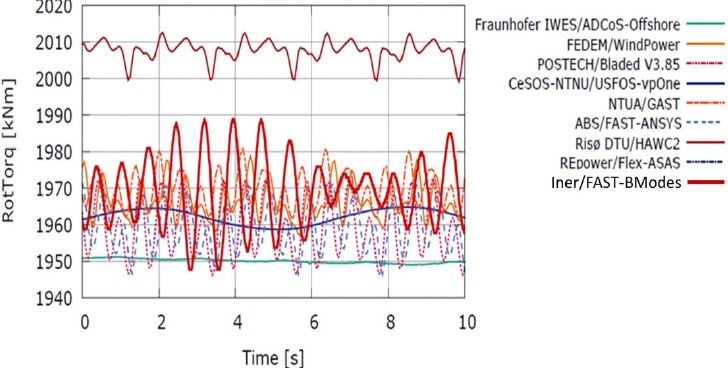
Figure 13. Analysis Result for Load Case 3.2 of OC4 Phase I (Low ‐ Speed Shaft Torque).